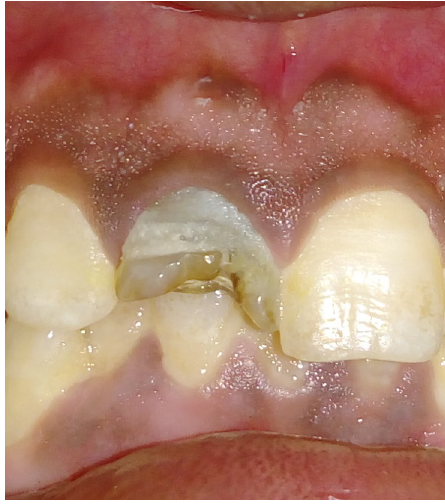
Fig. 1. Pre-operative photograph showing non-vital hopeless tooth root (case inclusive